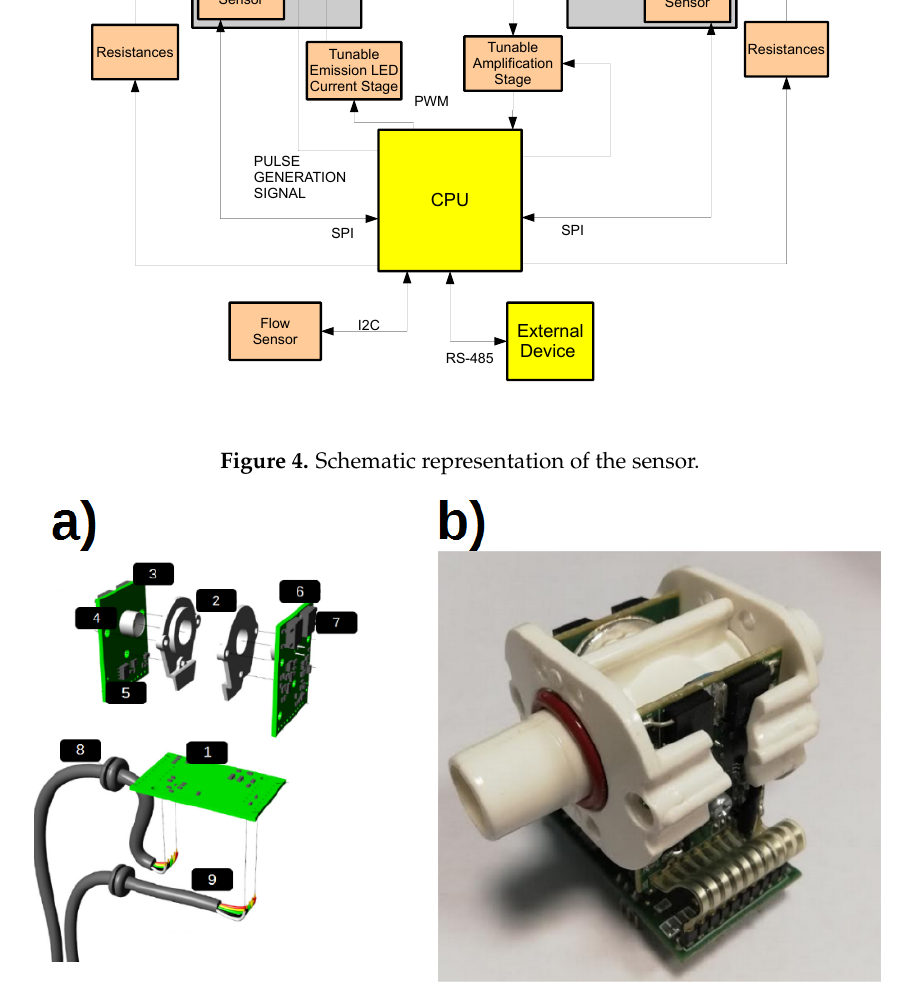
Figure 5. ( a ) Exploded drawing of the CO 2 sensor: (1) CPU board; (2) aluminum rings; (3) emitter board; (4) InAsSb/InAs element; (5) digital temperature sensor; (6) receiver board; (7) heating resistances; (8) Flow sensor communication cable; (9) power supply/RS-485 cable. ( b ) Assembly of the developed CO 2 and plastic